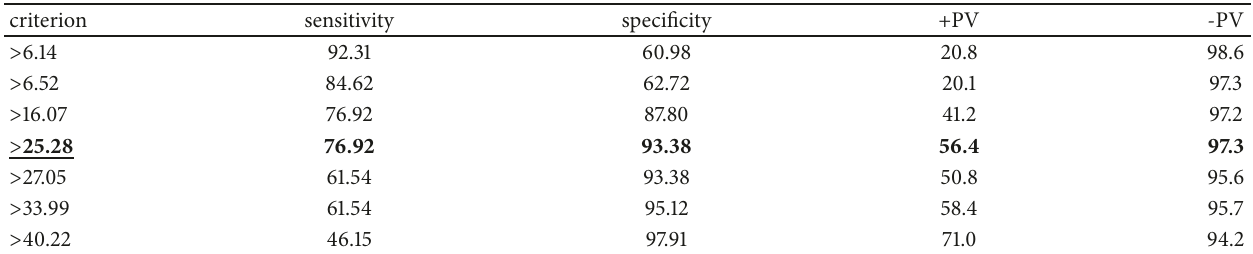
Table 5: Sensitivity, specificity, positive predictive value, and negative predictive value of different cutoff values of ARR.